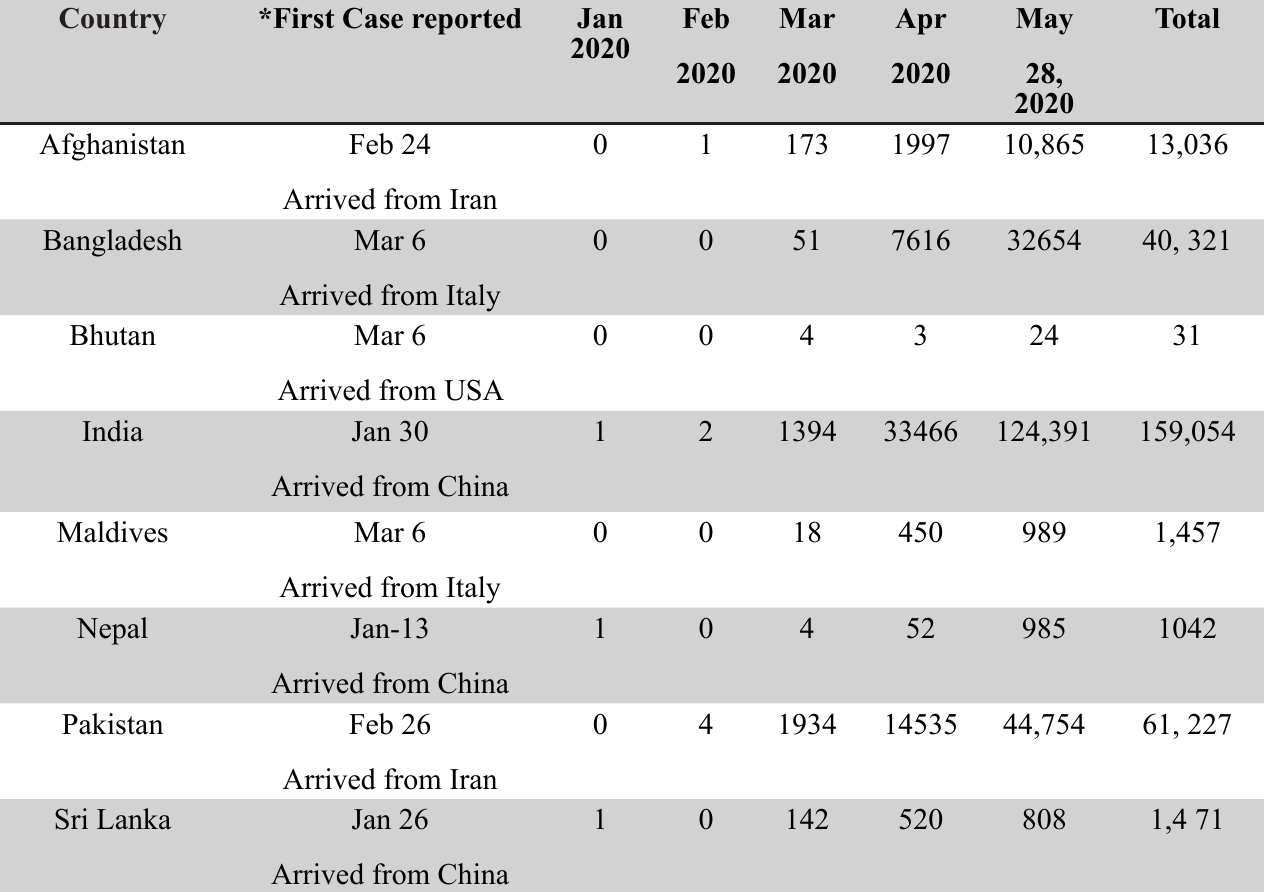
Table 1. Number of new cases reported month wise Jan-May 28,2020 at 11.52